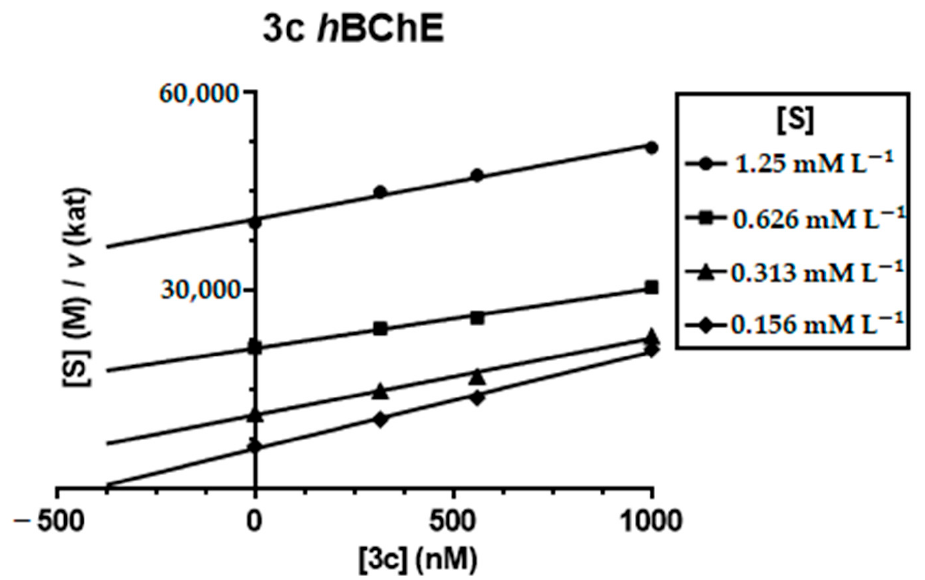
Figure 4. Steady-state inhibition of the h BChE substrate (human butyrylthiocholine) hydrolysis by compound 3c at different concentrations. Cornish − Bowden plots of (S)/ v against the (I) of the initial velocity at increasing substrate concentrations (2.5–20.0 mM) are presented. Lines were derived from the linear regression of the data points. Each point is the average of three determinations. The parallel lines indicate a competitive inhibition of h BChE by 3c , which means a reversible binding mode to the active site of the enzyme. With the increasing concentration of the inhibitor, the apparent V max remained unchanged and K m increased. A K i value of 173 ± 25 nM was determined for 3c on h